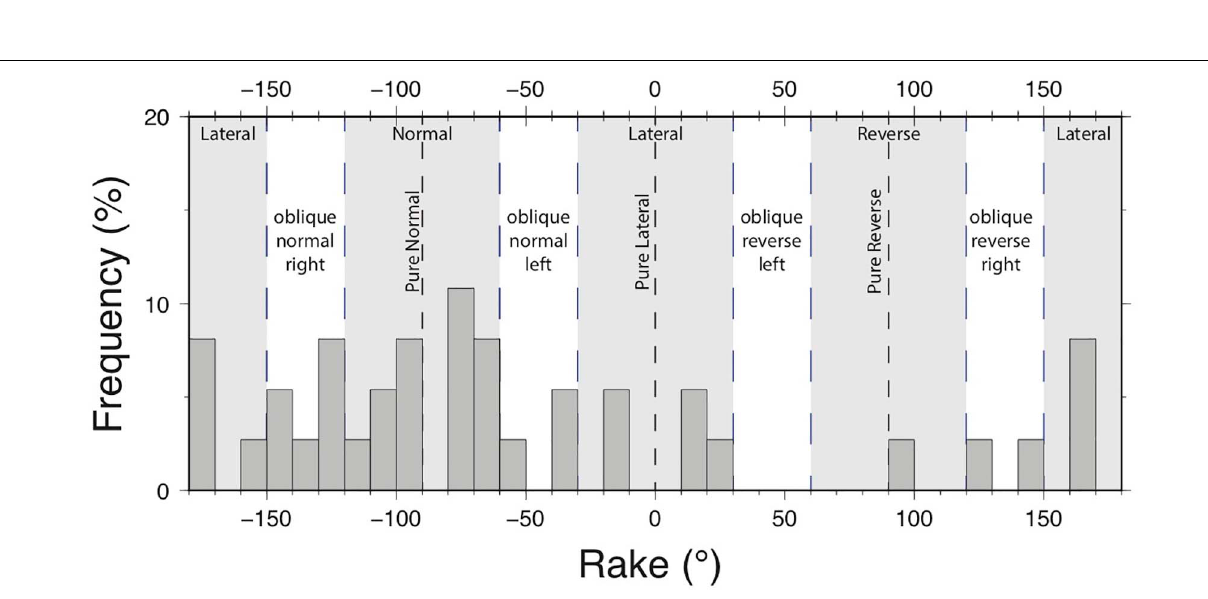
FIGURE 6 | Histogram of the rake of the calculated focal mechanisms for “Italy”